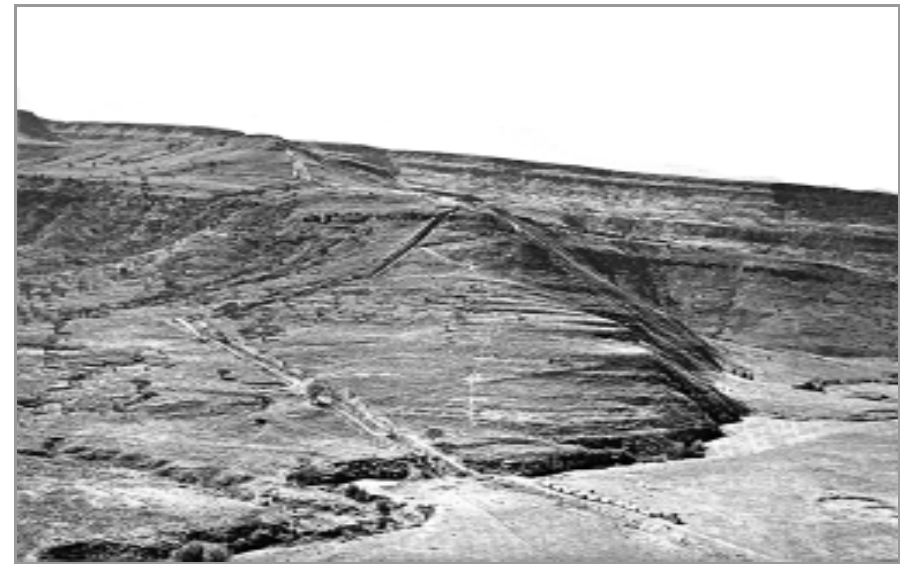
Illustration 5: The Tukhela water transfer scheme under construction